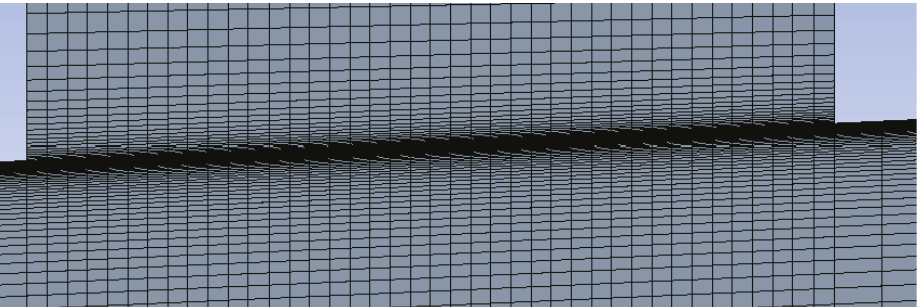
Figure 4: Near view at the injection slot in grid 2.